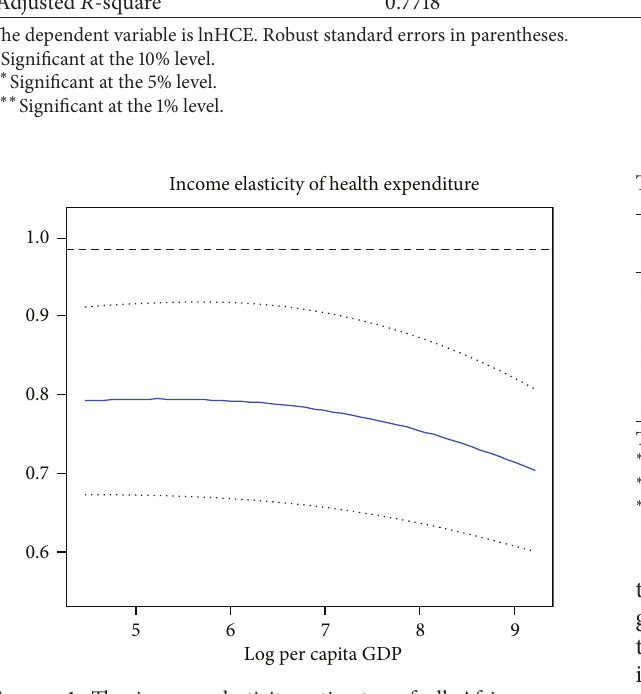
Figure 1: The income elasticity estimator of all African coun- tries, the solid curves represents 𝑚 󸀠 ( lnGDP ) .The dotted curves correspond to its 95% confidence interval. The level dashed line represents the estimate from the linear model.